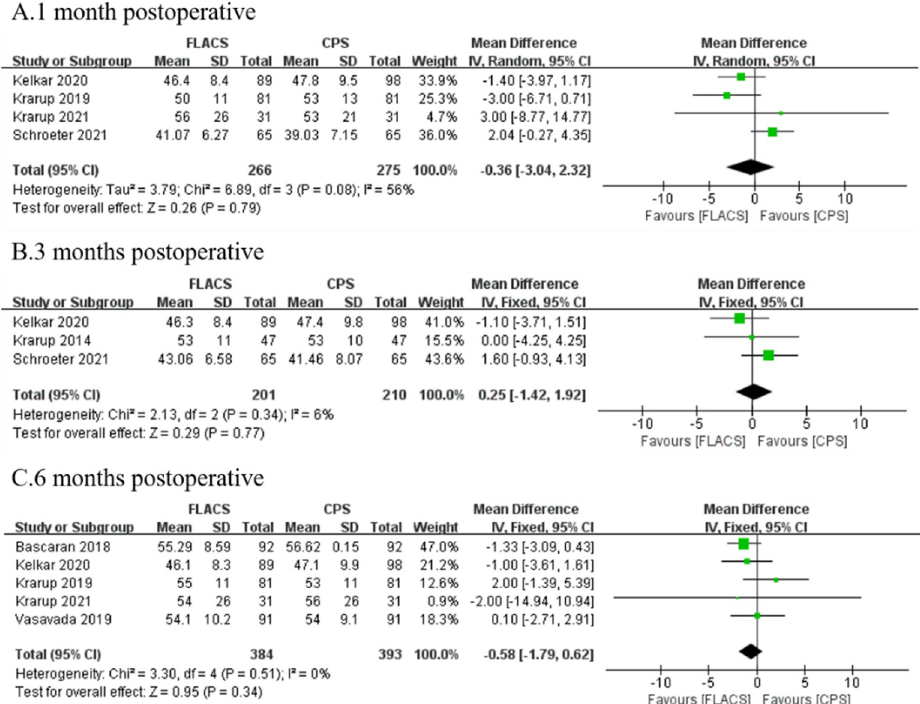
Fig 6. Forest plot of postoperative 6A between FLACS and CPS at A. 1 month, B. 3 months, and C. 6 months.